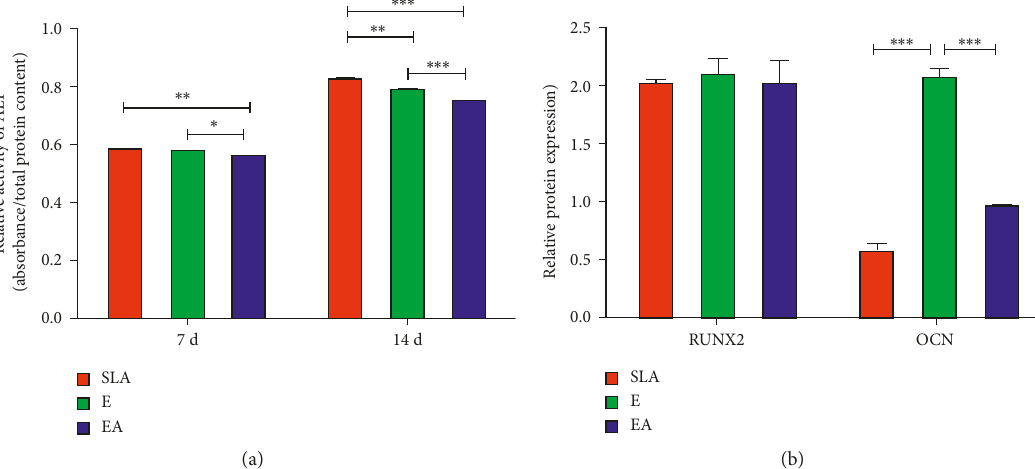
Figure 7: Relative activity of ALP after culturing for 7 d and 14d of osteoinduction (a) and OCN and RUNX2 production on the 7th day of osteoinduction (b) ( ∗ P < 0 . 05; ∗∗ P < 0 . 01; ∗∗∗ P < 0 .